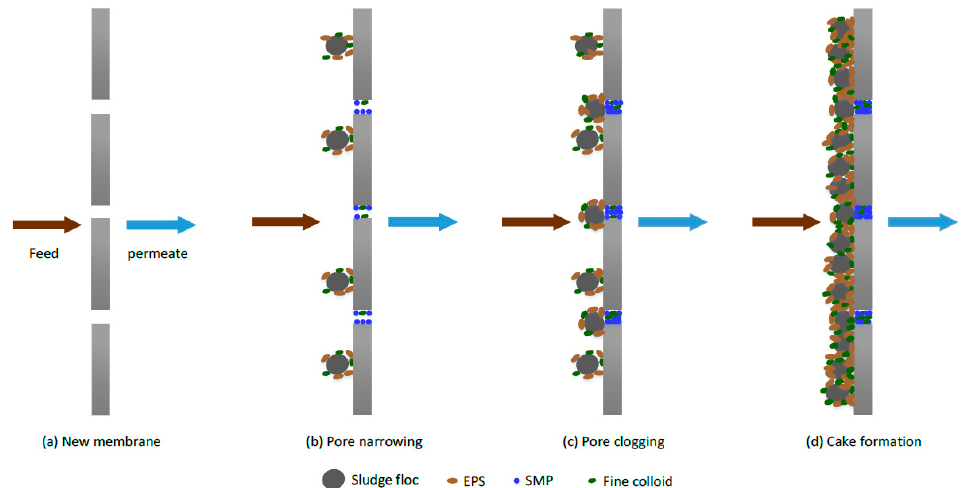
Figure 6. Schematic representation of membrane fouling mechanisms in MBRs showing different stages of fouling, ( a ) New membrane; ( b ) Pore narrowing; ( c ) Pore clogging; ( d ) Cake formation [202].